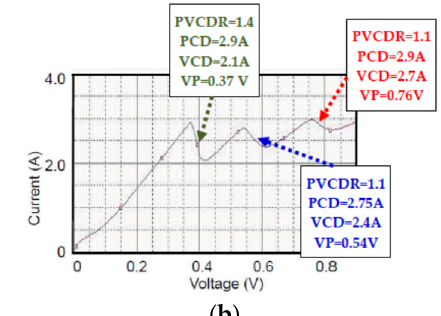
Figure 8. ( a ) The construction of triple PVCDR RTEC structure. ( b ) NDR curve of triple PVCDR RTEC structure.